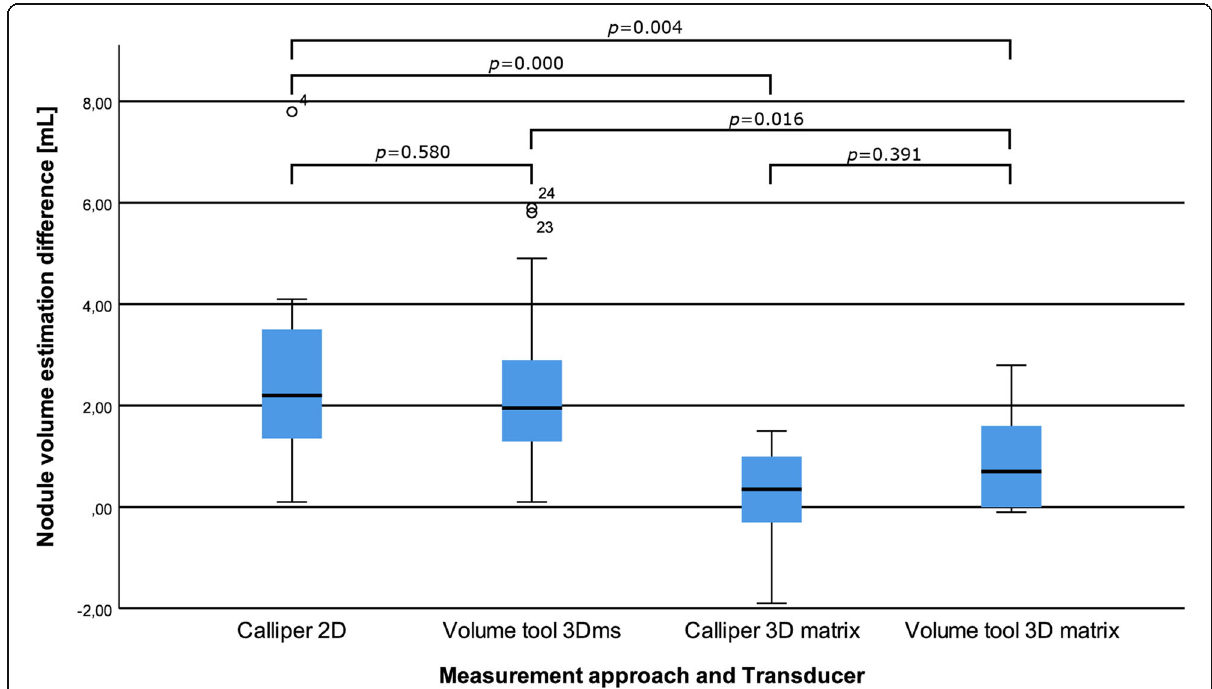
Fig. 2 Boxplot of the differences in mL of the volume estimation measurements as compared to the reference value per transducer and measurement approach with corresponding p